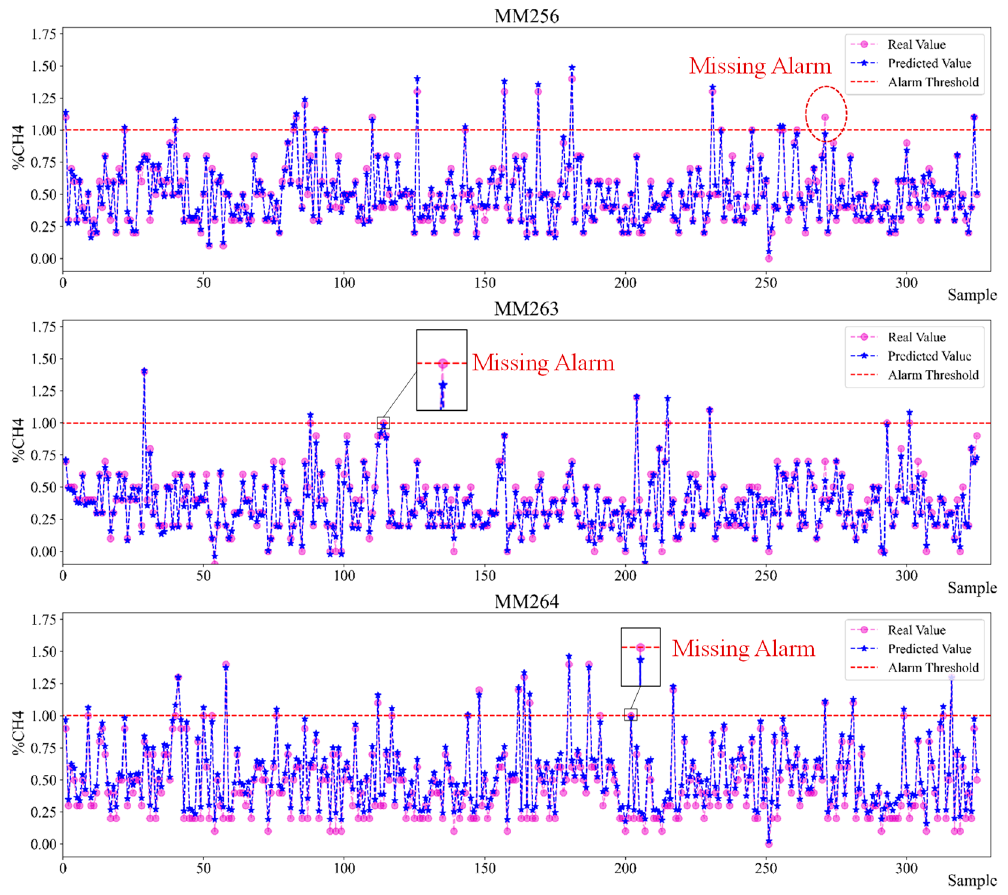
Figure 13. Prediction results of Bi-LSTMs dynamic optimized combined indicators model.